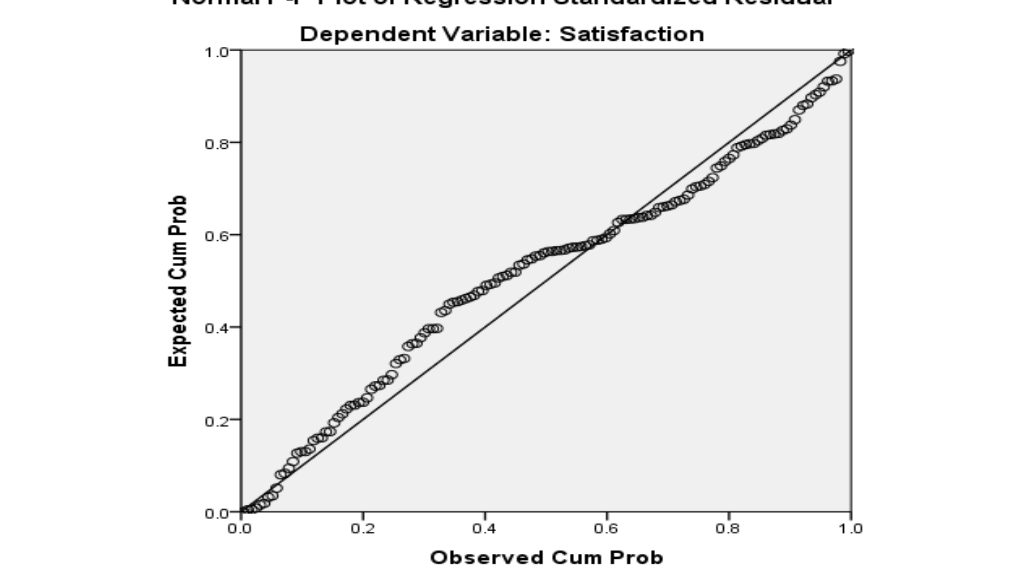
Figure 2 Linearity of the Relationship Between Satisfaction and the Independent